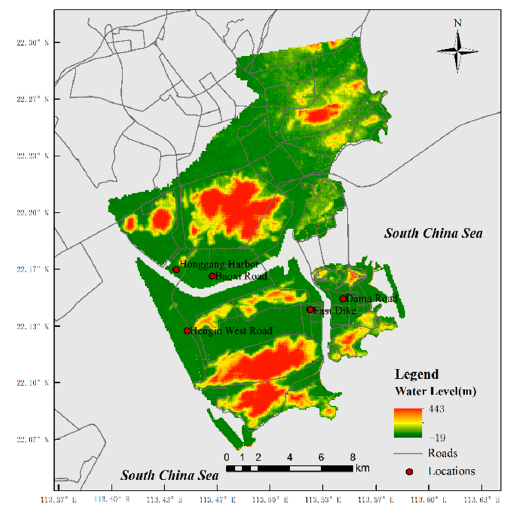
Figure 10. Photos of typical locations. ( a ) Honggang Harbor, t = 330 min (16:00); ( b ) Hengqin West Road, t = 115 min (12:25); ( c ) Baoxi Road, t = 140 min (12:50); ( d ) East Dike, t = 300 min (15:30); ( e ) Dama Road, t = 105 min (12:15).